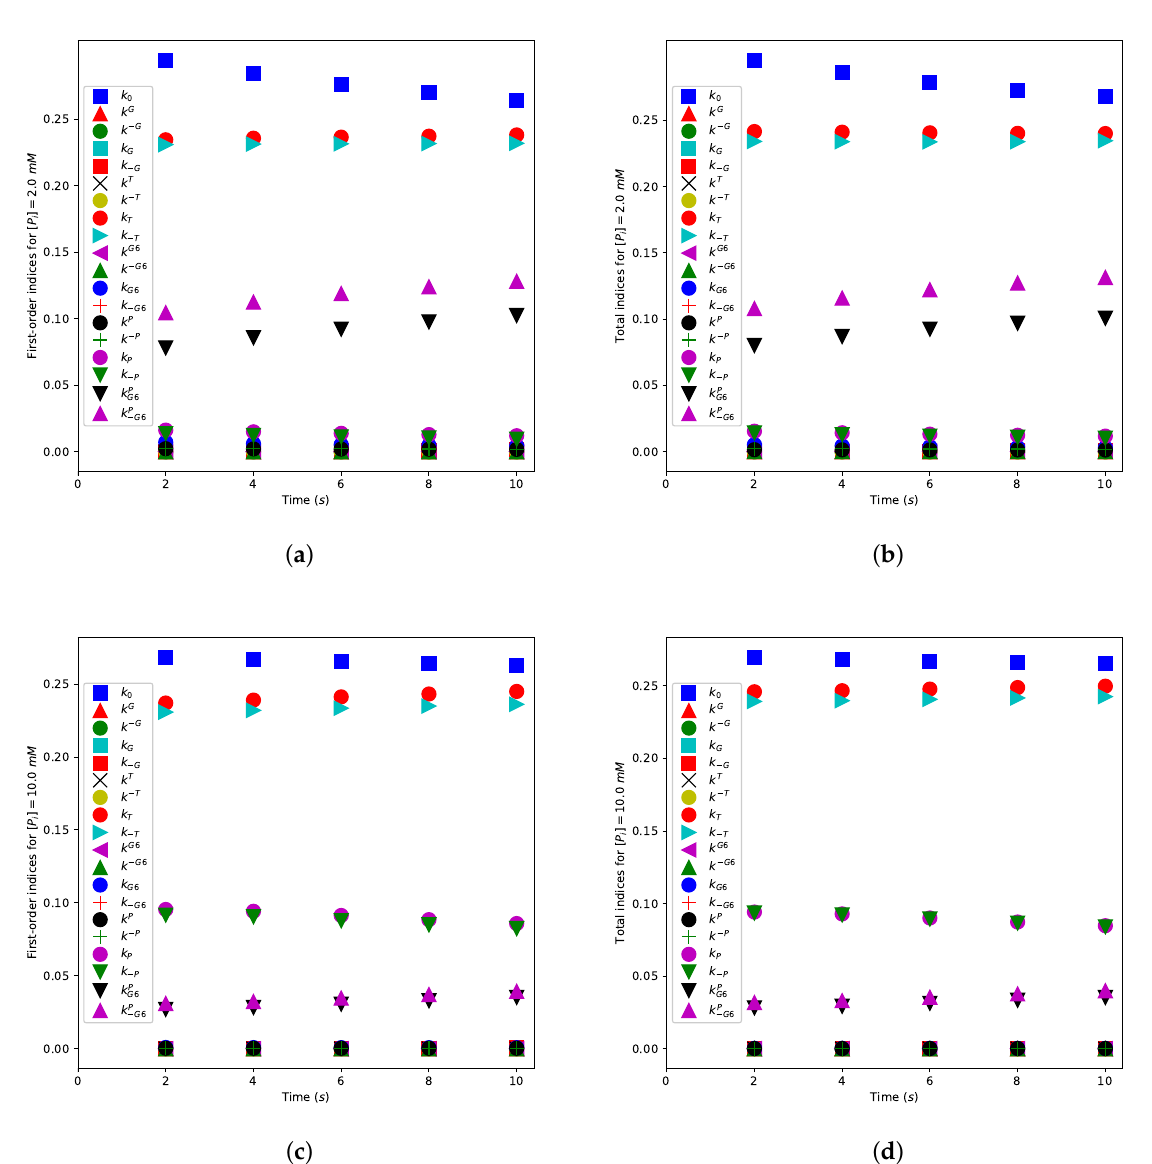
Figure 10. Results of the global sensitivity analysis. ( a ) First-order sensitivity indices ( S 1) and ( b ) total sensitivity indices ( ST ) with [ P i ]( t = 0 ) = 2.0 mM. ( c ) First-order sensitivity indices and ( d ) total sensitivity indices with [ P i ]( t = 0 ) = 10.0 mM. The indices are calculated at the times t = 2,4,6,8,10 s. The remaining parameter values are given in the main body of the